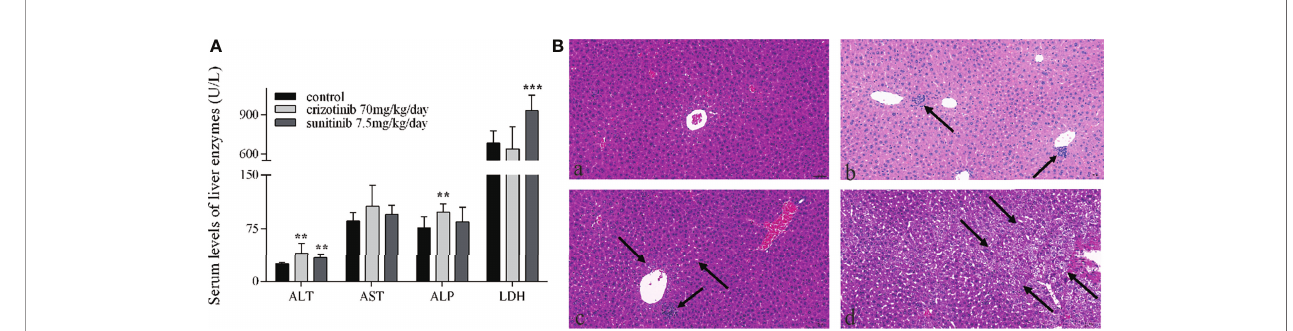
FIGURE 2 | The hepatotoxicity of crizotinib and sunitinib in vivo . (A) Blood levels of different liver enzymes in male ICR mice after the administration of crizotinib or sunitinib treatment (n = 8). (B) Histopathological analysis of liver micro-tissues from animals in the different experimental groups. Representative images from: (a) control group; (b) crizotinib-treated animals, 70 mg/kg/day; (c, d) sunitinib-treated animals, 7.5 mg/kg/day. Magni fi cation of photomicrographs at 20x. **P < 0.01 or ***P < 0.001 (the crizotinib or sunitinib alone vs. control). ALT, alanine aminotransferase; AST, aspartic acid transferase; ALP, alkaline phosphatase; LDH,